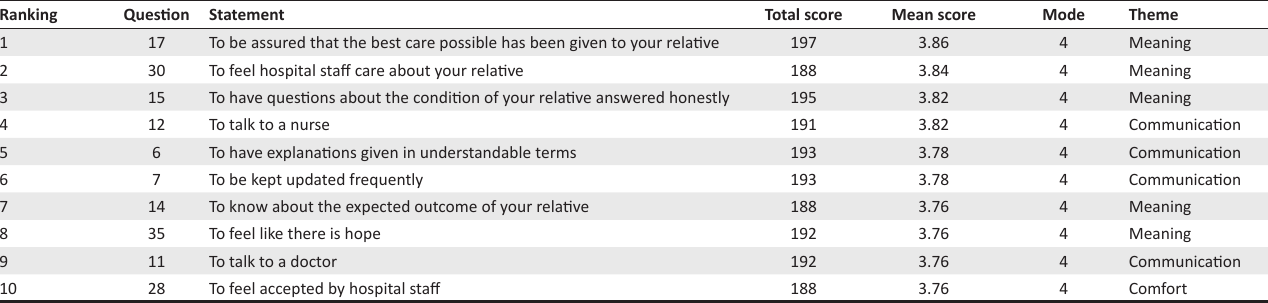
TABLE 2: Top 10 ranked needs statements CCFNI-1 (level of importance). Ranking